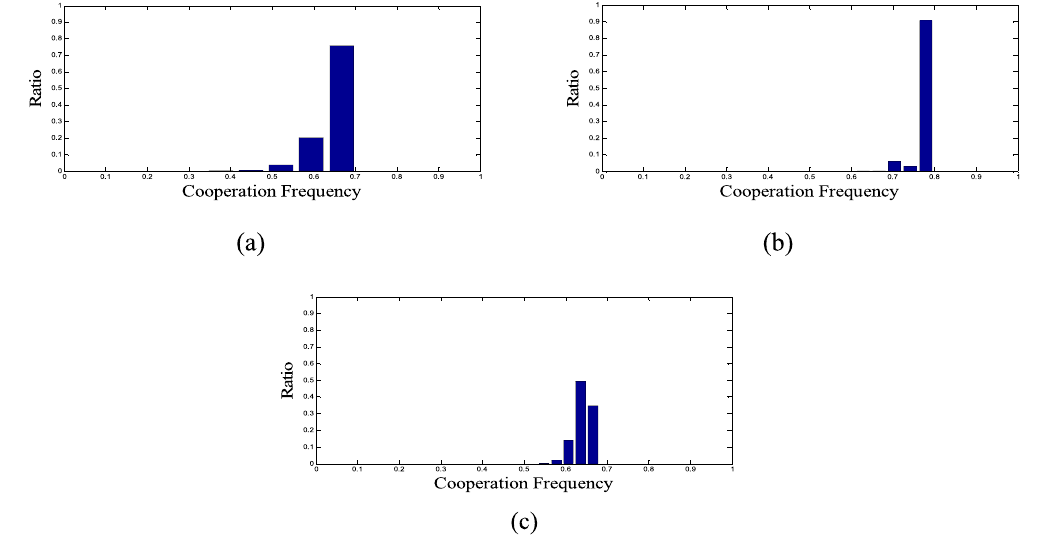
Figure 2. The evaluation distribution obtained under the multi-sampling method. Different sampling numbers have been tested. ( a ) 5 samplings, ( b ) 10 samplings, and ( c ) 20 samplings. On the whole, the multi-sampling method can help reduce the evaluation error of structures. However, different sampling numbers may be necessary toward different evaluation distributions of different structures, which explains why the fluctuation range in Fig. 2(c) is wider than in Fig.